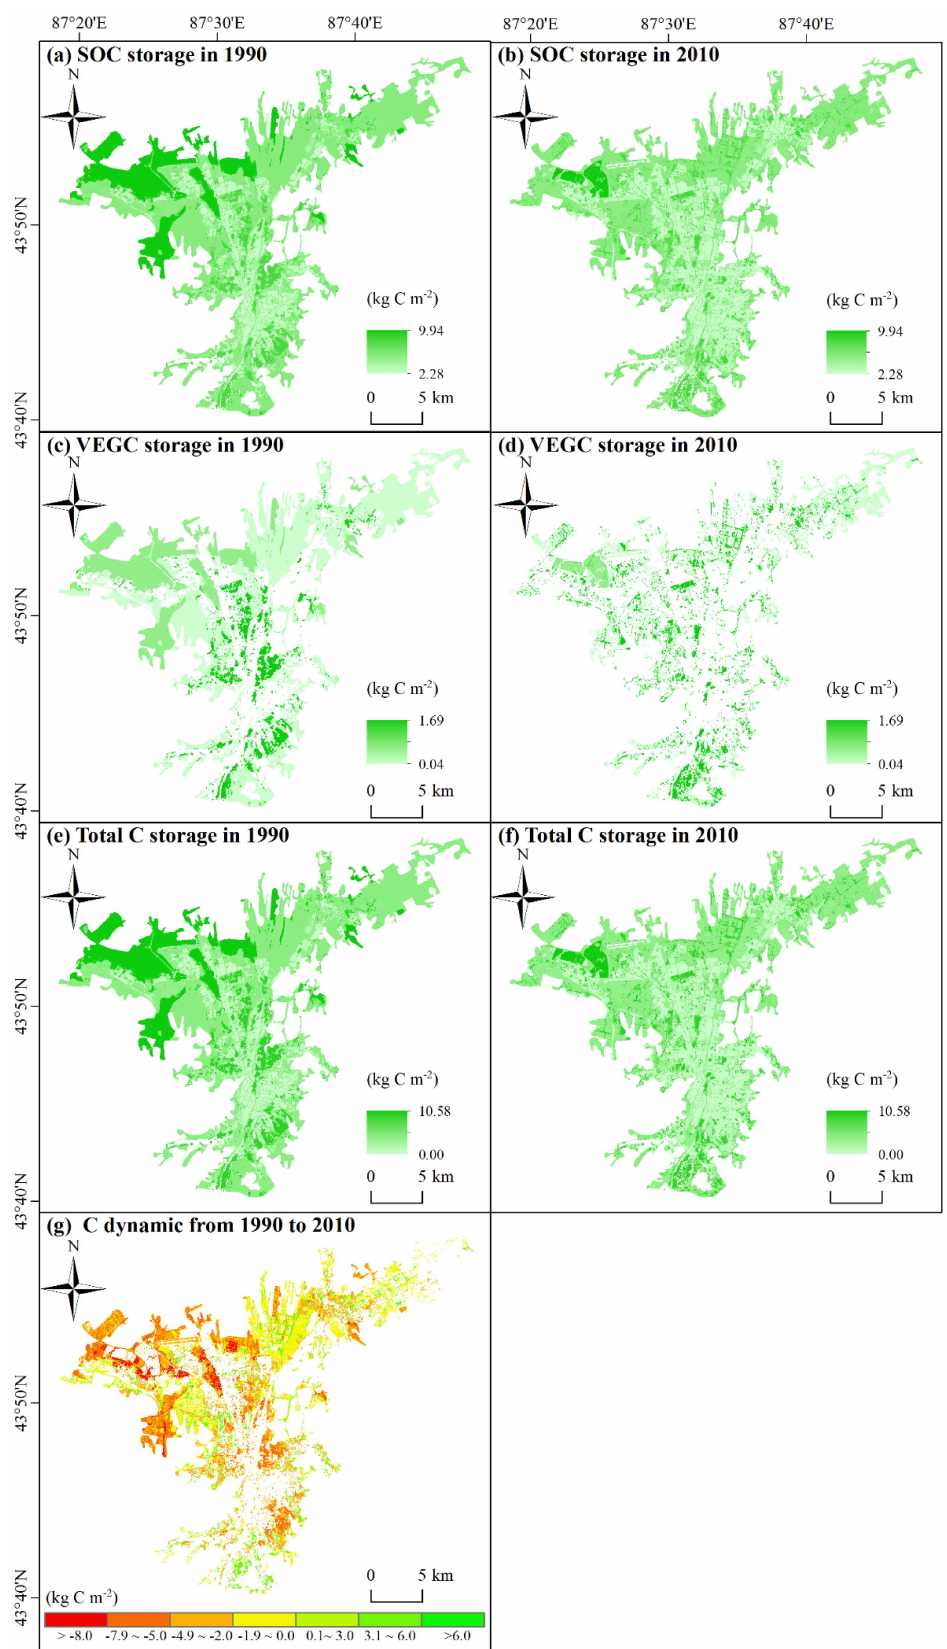
Figure 6. Spatial patterns of the ecosystem C pools in 1990 and 2010 ( a – f ) and the C dynamics in response to land-cover change from 1990 to 2010 in Urumqi ( g